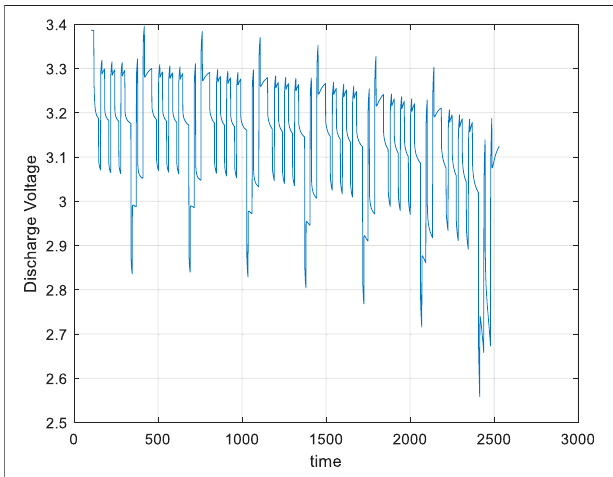
FIGURE 13 | Voltage under DST operating conditions.